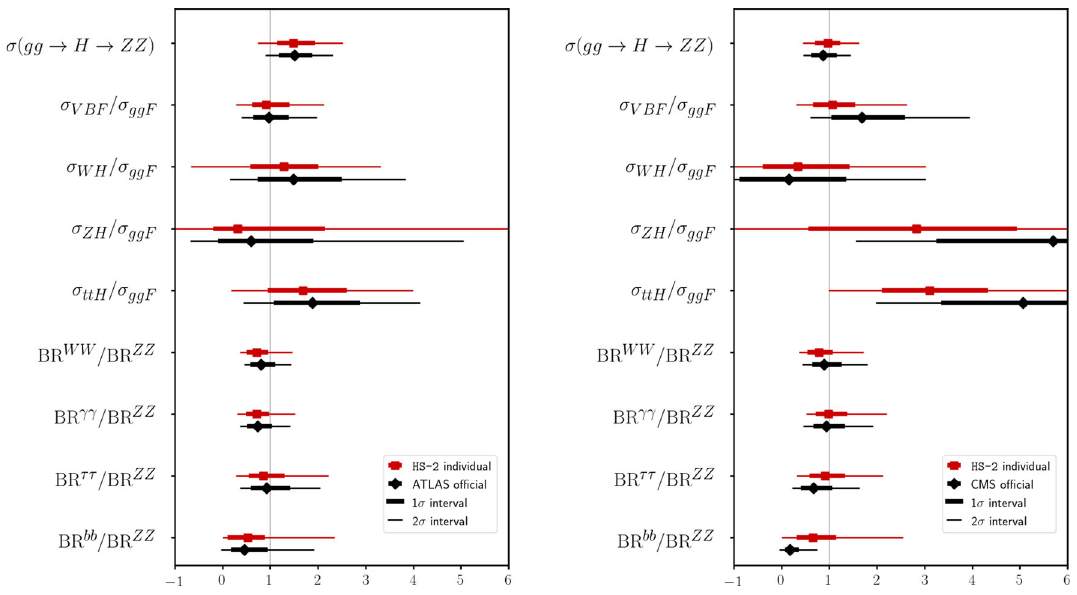
Fig. 9 Results obtained with HiggsSignals-2 in comparison with the official ATLAS-only ( left panel ) and CMS-only ( right panel ) fit results for the σ( gg → H → Z Z ) cross section and for ratios of cross sections and branching fractions. The HiggsSignals-2 results and